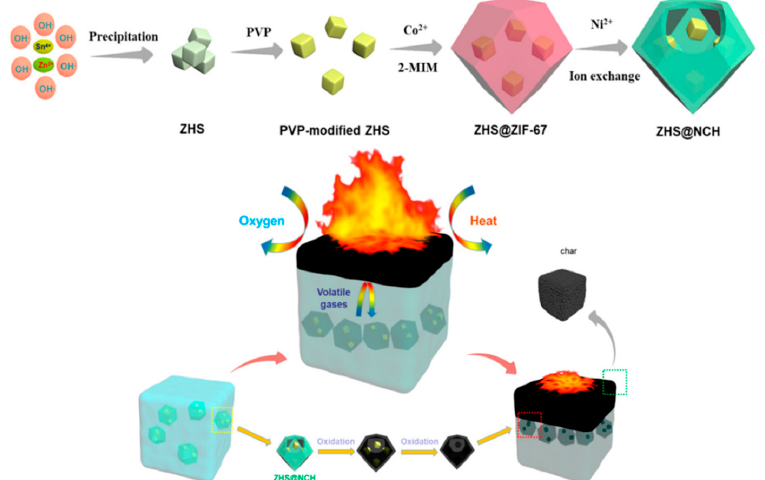
Figure 11. Schematic illustration for preparation process of ZHS@NCH and Schematic illustration of flame-retardant mechanism for ZHS@NCH. Reprinted with permission from Ref. [152]. Copyright 2019, American Chemical Society.